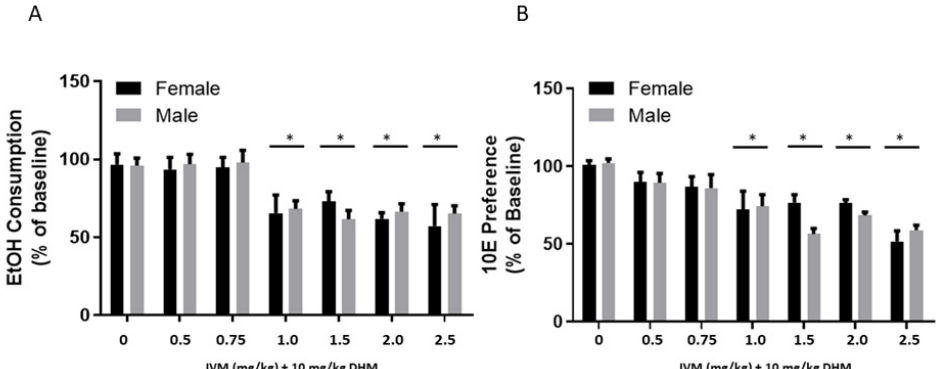
Figure 4. DHM (10 mg/kg) combined with IVM significantly reduces the dosing for EtOH consumption and 10E preference over 24 h in male and female C57BL/6J mice with no sex-specific differences. ( A ) DHM combined with IVM (1.0–2.5 mg/kg) significantly reduced EtOH consumption 24 h post-treatment with no sex-specific differences between normalized con- sumption values. Similarly, ( B ) DHM combined with IVM (1.0–2.5 mg/kg) significantly reduced 10E preference 24 h post- treatment with no sex-specific differences between normalized consumption values. IVM = ivermectin; DHM = dihy- dromyricetin; Baseline = day 0 values presented in Figures 1 and 3 for males and females, respectively. * p < 0.05 vs. sex- matched baseline values ( n = 48/group for DHM and saline controls; n = 8/group for IVM and IVM + DHM groups). All values are shown as averages ± SEM. 2-way ANOVA followed by Bonferroni’s multiple comparisons.